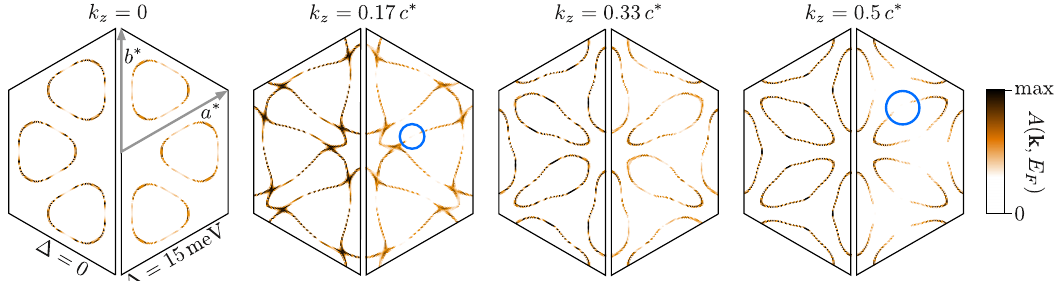
Figure 4: The spectral function of VSe the CDW gap is most pronounced. The four plots correspond to different values of k . In each, the left(right) side shows the ungapped(gapped) phase above(below) z T . All plots employ the same colour scale. We employed a spectral broadening of c Σ = 15 i meV, and a constant gap ∆ = 15 meV. The blue circles highlight two gapped regions separated by Q = ( 0,0.25,0.33 )